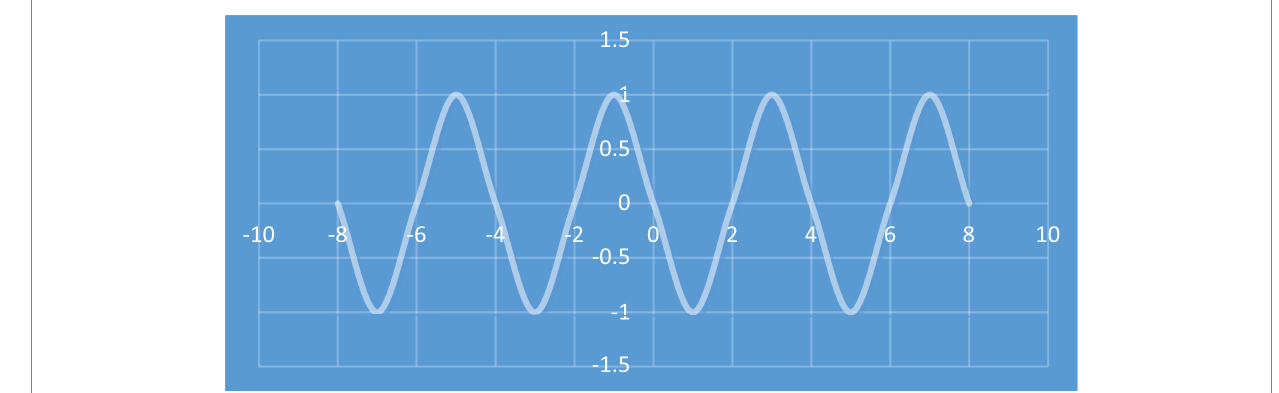
FIGURE 6 Visual representation of a sequence that oscillates between two values.